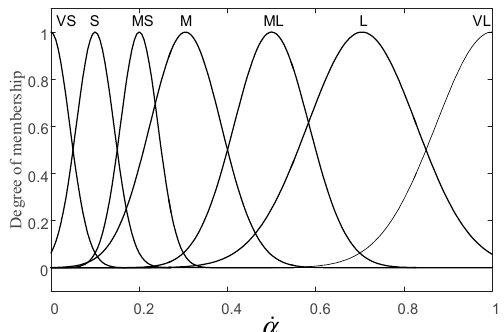
Figure 10. Pedal opening change rate membership function.